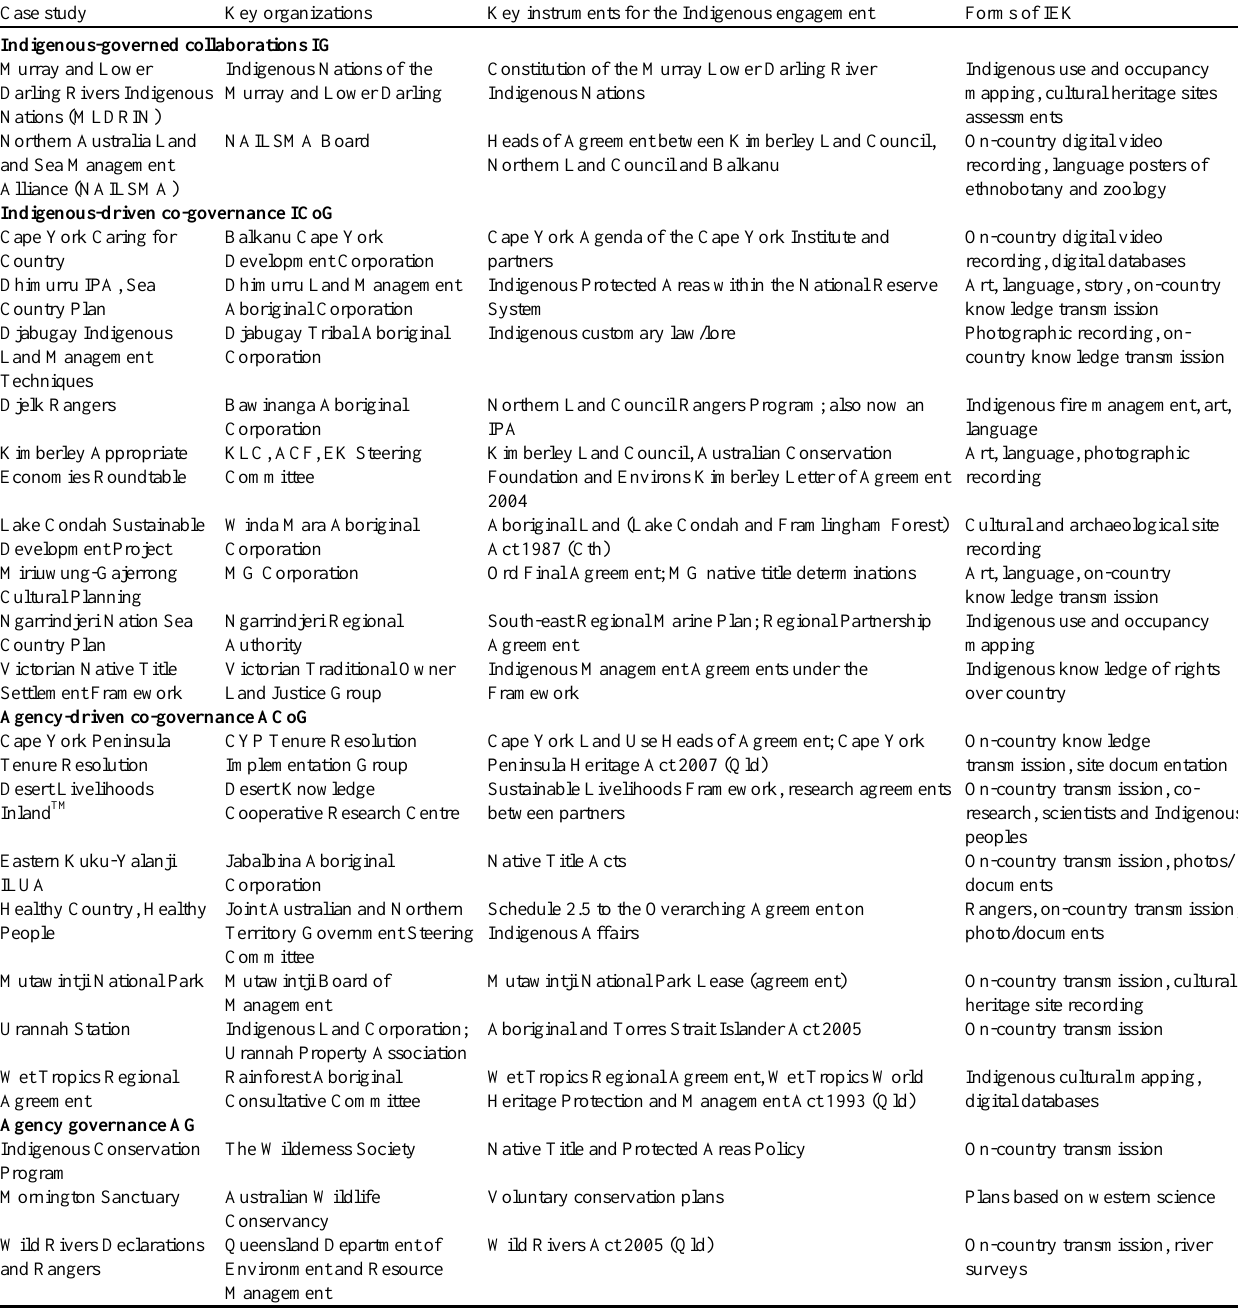
Table 1 . The case